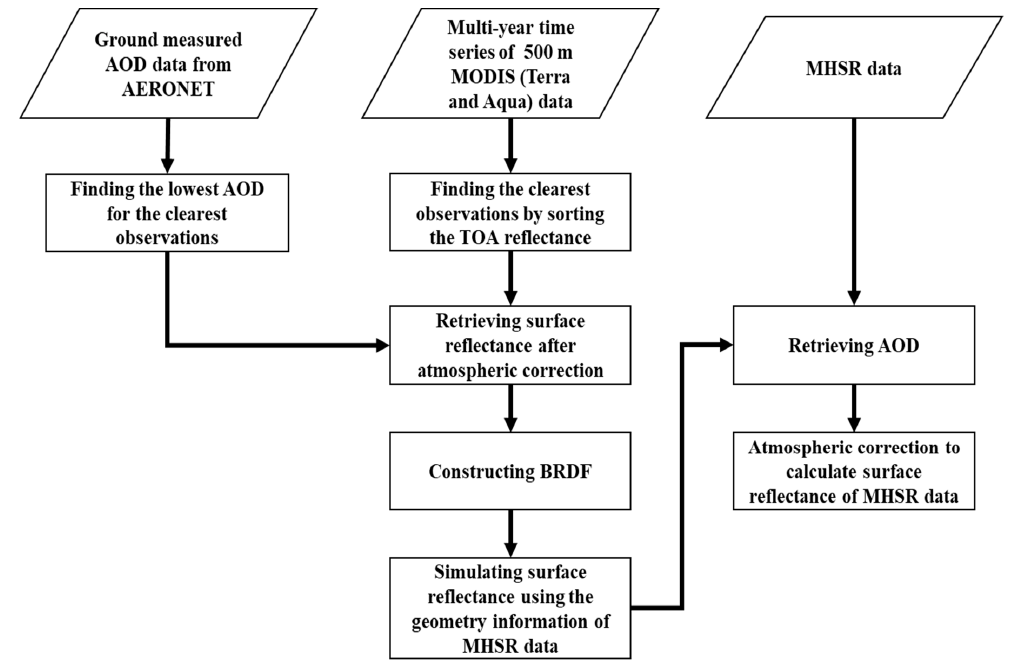
Figure 1. Flowchart of the new aerosol optical depth (AOD) retrieval method.